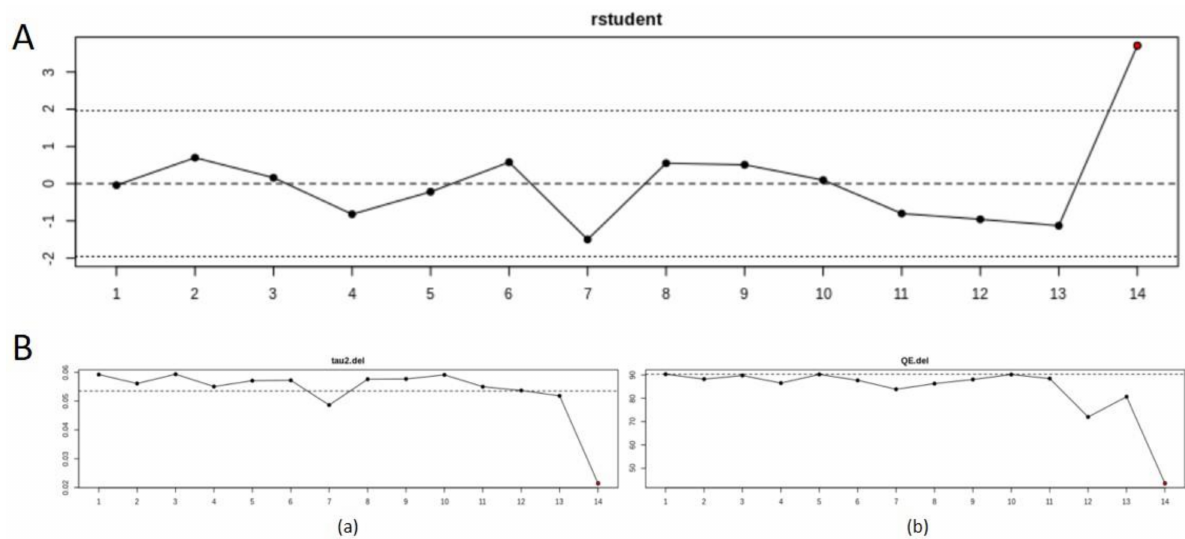
Figure 3. Plot of the influence diagnostics. ( A ) Plot of the externally standardized residuals as a function of each of the studies. Potential influence point. ( B ) Plot of the leave-one-out estimates of the amount of heterogeneity ( a ) and leave-one-out values of the test statistics for heterogeneity ( b ) as a function of each of the studies (optimal value = 100). Potential influence point.